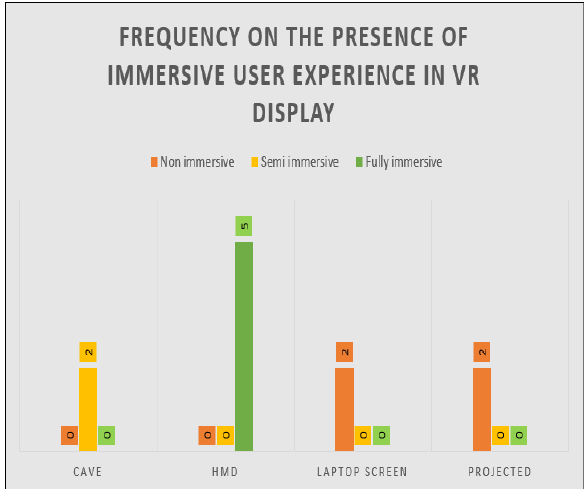
Figure 3 . Frequency on the Presence of Immersive User Experience in VR